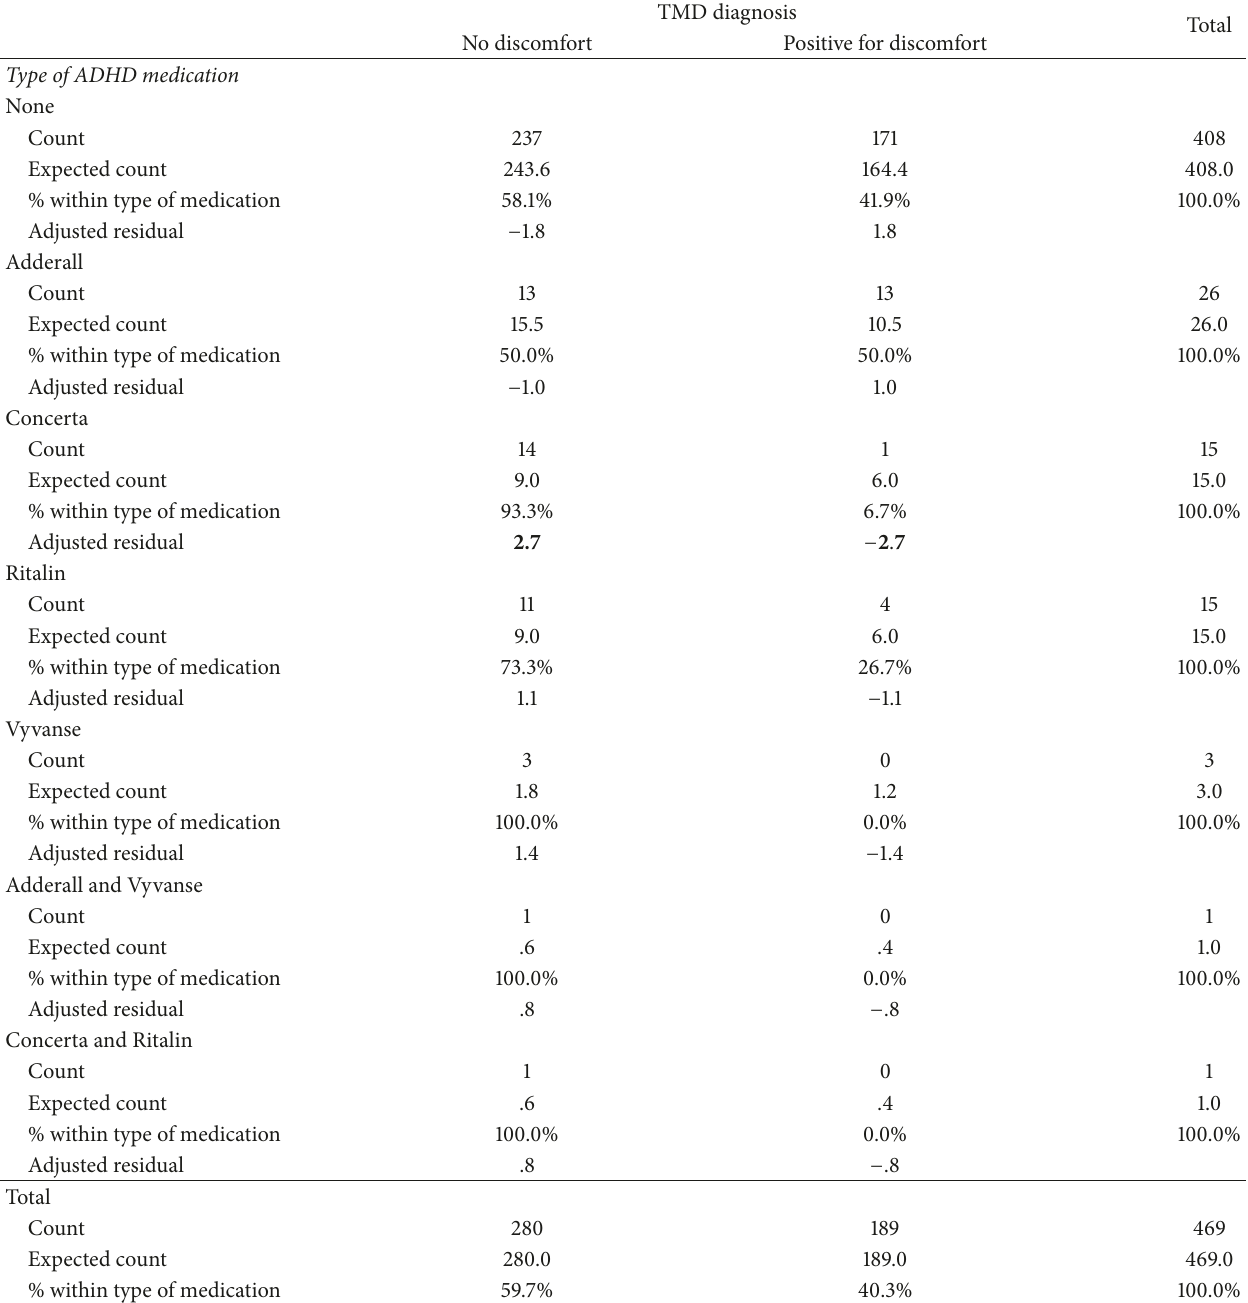
Table 1: Comparison of the type of ADHD medication by the presence of TMD symptoms. The results show that Concerta is the ADHD medication that is significantly different compared to the